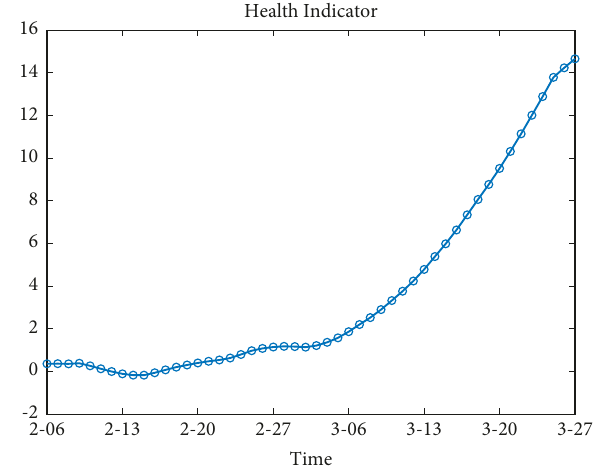
Figure 7: 50d final health index